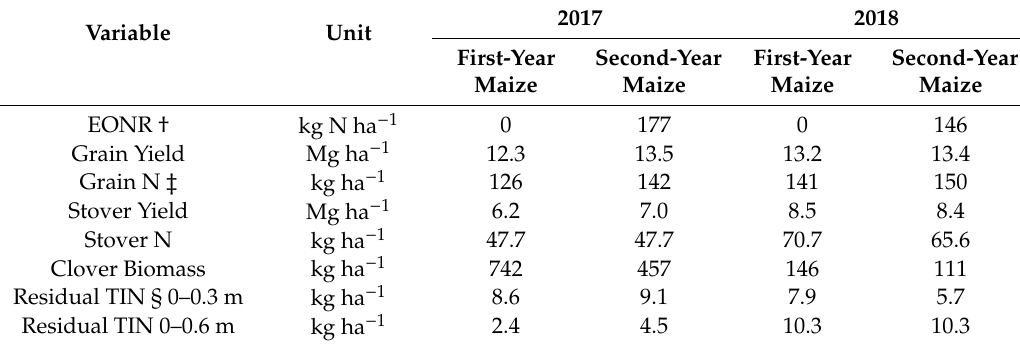
Table 4. Level of dependent variables in first- and second-year maize at the economic optimum nitrogen rate (EONR) in 2017 and 2018.